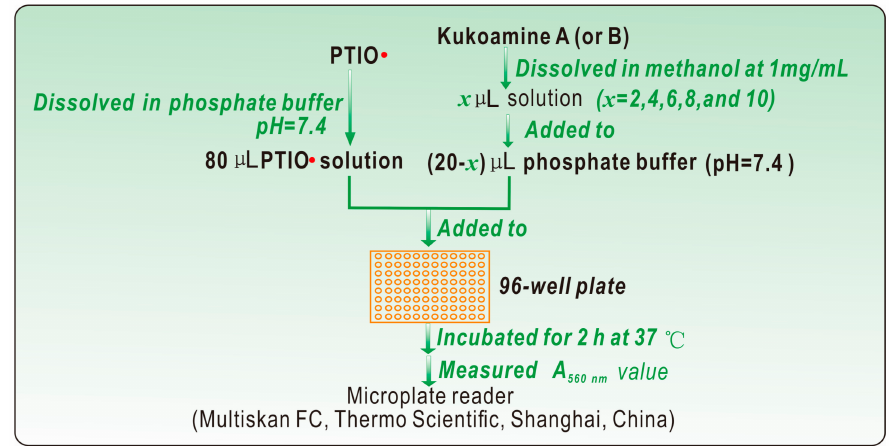
Figure 10. Experimental procedures for the PTIO • -scavenging assay. The above experiment was repeated using phosphate buffers with different pH values, including pH 4.0, 5.0, 6.0, 7.0 and